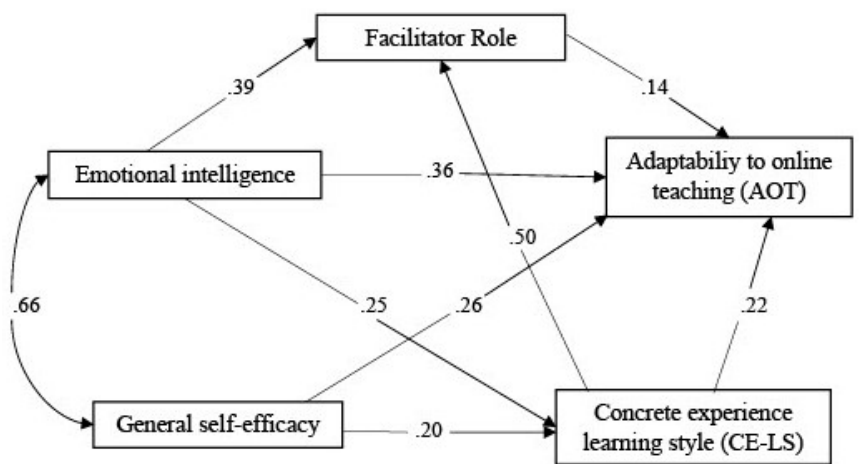
Figure 2. Mediation model of the relationship between EI, general self- efficacy, and AOT.